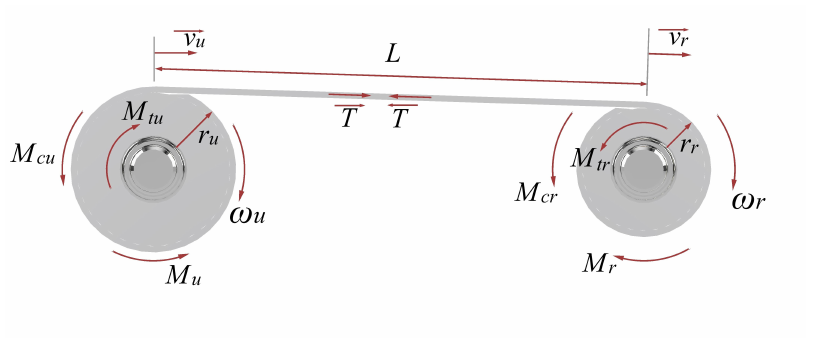
Figure 2. The web between two rolls.